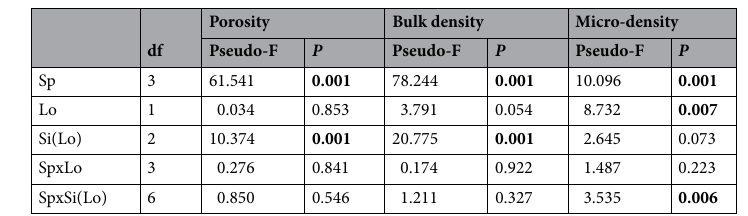
Table 2. Results of the PERMANOVA analysis for porosity, bulk density, and micro-density in the control and seep sites at Dobu and Upa Upasina for Acropora millepora , Galaxea fasciularis , Pocillopora damicornis , and massive Porites . Significant values are reported in bold. Sp species, Lo location, Si site.